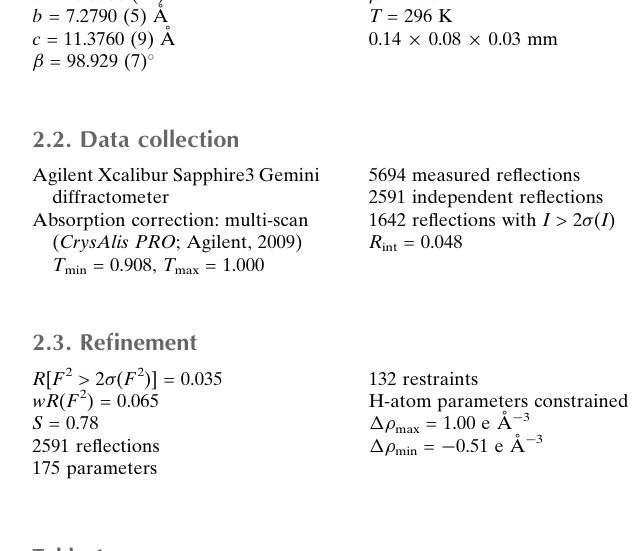
Hydrogen-bond geometry (A˚ , (cid:4)